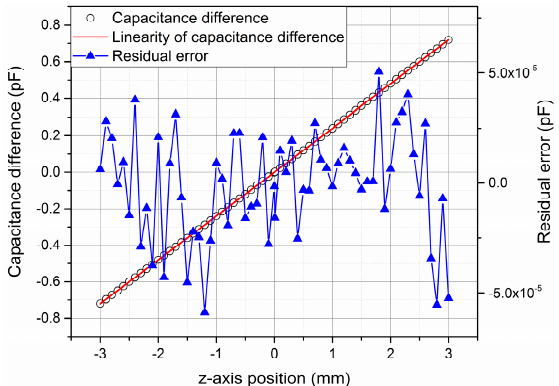
Figure 2. Simulation result of differential capacitance value over the range of ±3 mm along the z-axis.